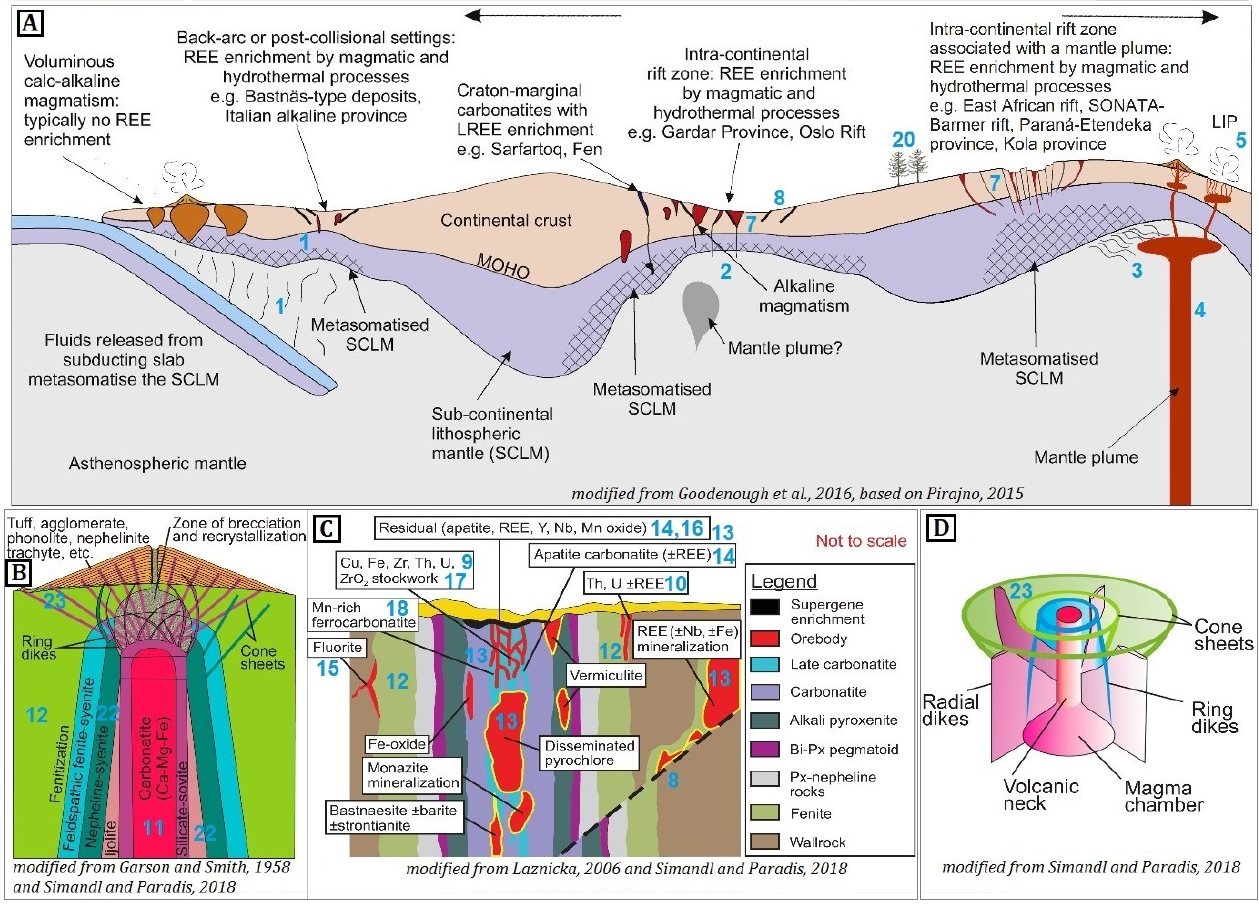
Figure 3. Idealised genetic model of a carbonatite–alkaline-complex-related REE mineral system (adapted from Aranha et al., 2022) cross- referenced to processes listed in Table 2 through the numbers in blue. Panel (a) depicts the fertility and geodynamic setting along with the transport architecture on a regional scale. Panels (b–d) focus on the emplacement architecture at the camp-to-prospect-scale. Panel (b) shows the idealised geometry of the intrusion and the relation of carbonatites and associated alkaline rocks and fenitisation. Panel (c) presents the near-surface structural architecture and the spatial distribution of associated rocks. Panel (d) displays the idealised geometry of a carbonatite– alkaline intrusion and the relationship between the magma chamber, ring dykes, cone sheets and radial